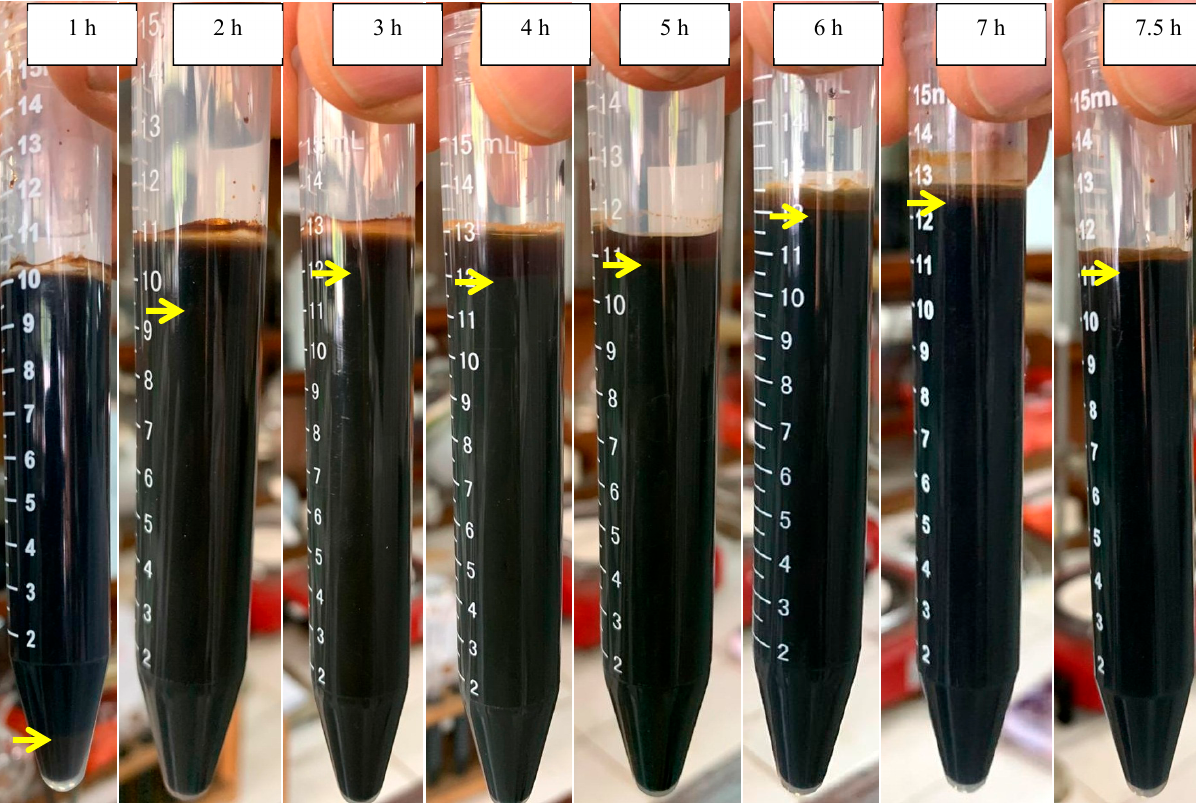
Figure 7. Settling at the initial pH of 7.